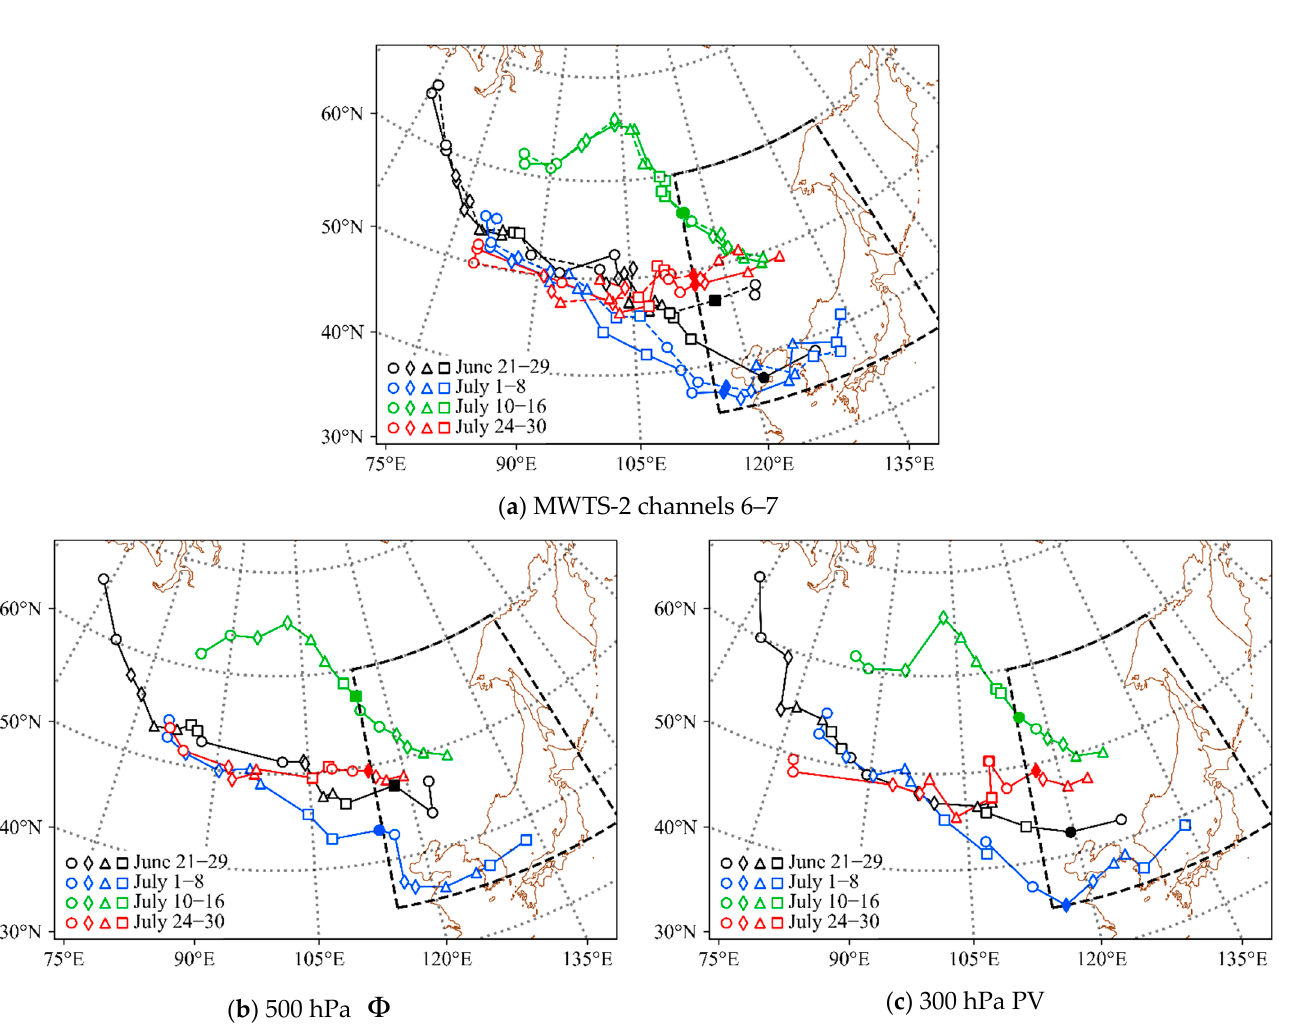
Figure 12. Tracks of the four NCCV cases in June and July 2019 identified by ( a ) high-brightness temperature centers of MWTS-2 channel 6 (solid) and channel 7 (dashed), ( b ) low geopotential height centers at 500 hPa, and ( c ) high potential vorticity centers at 300 hPa of ERA5 reanalysis. Two consecutive same symbols represent the cutoff low identified twice a day (ascending and descending nodes, 06:00 UTC and 18:00 UTC), and the solid symbols indicate the centers of cutoff lows which just entered the NCCV domain.